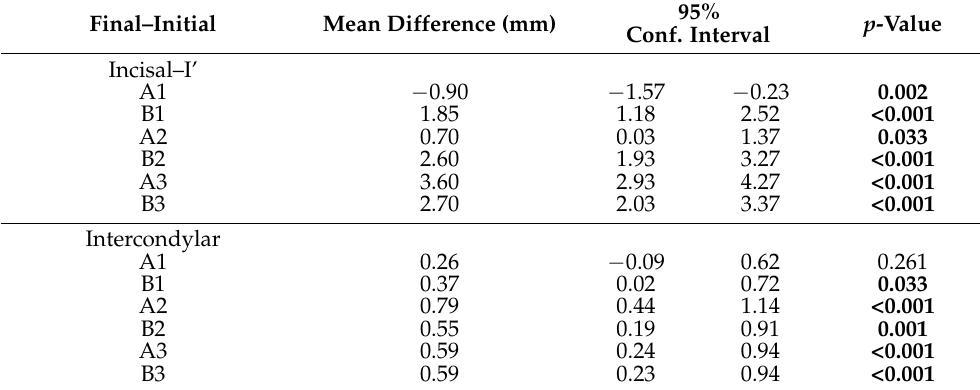
Figure 5. Estimated mean difference (Final–Initial) and 95% Confidence Interval per group and timing in Go–Menton (mandibular body length b).